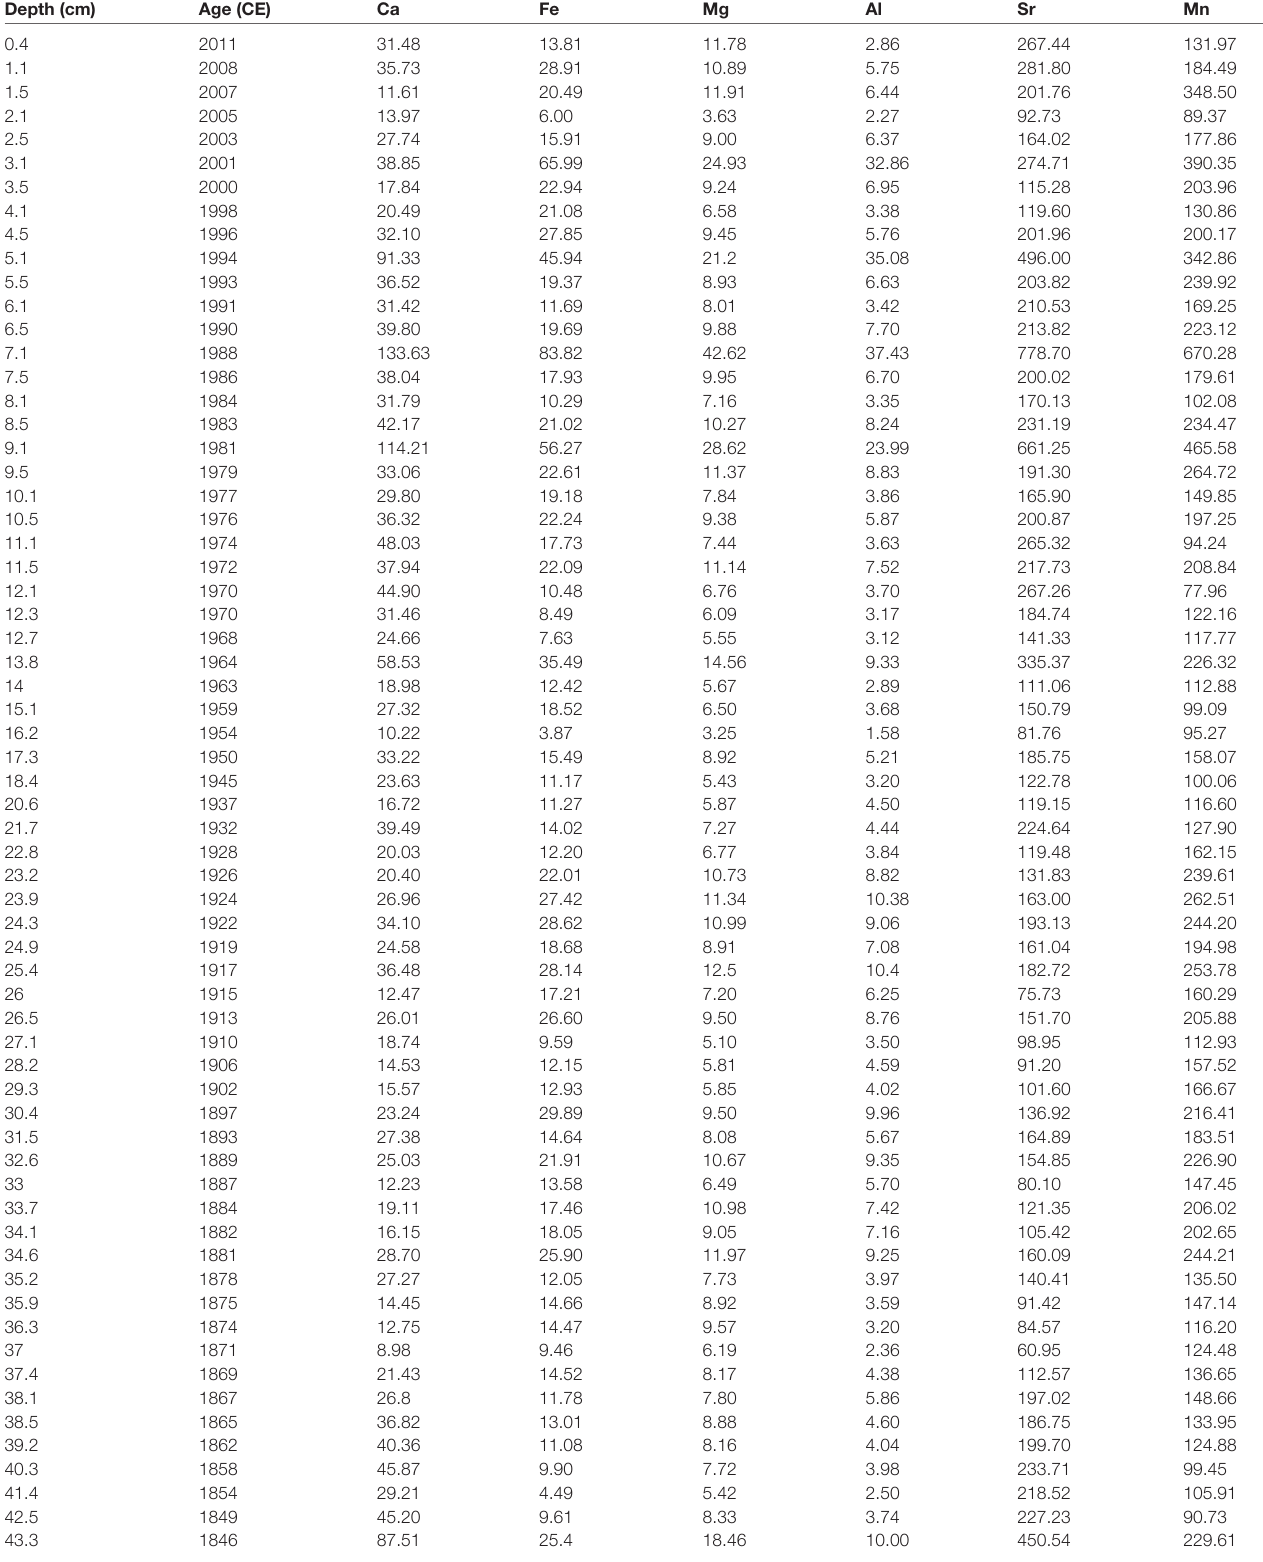
TABLE 3 | Acid-leachable (0.5 N HCl) elemental concentrations in the sediments of Core SBB-8-2012. Depth (cm) Age (CE)